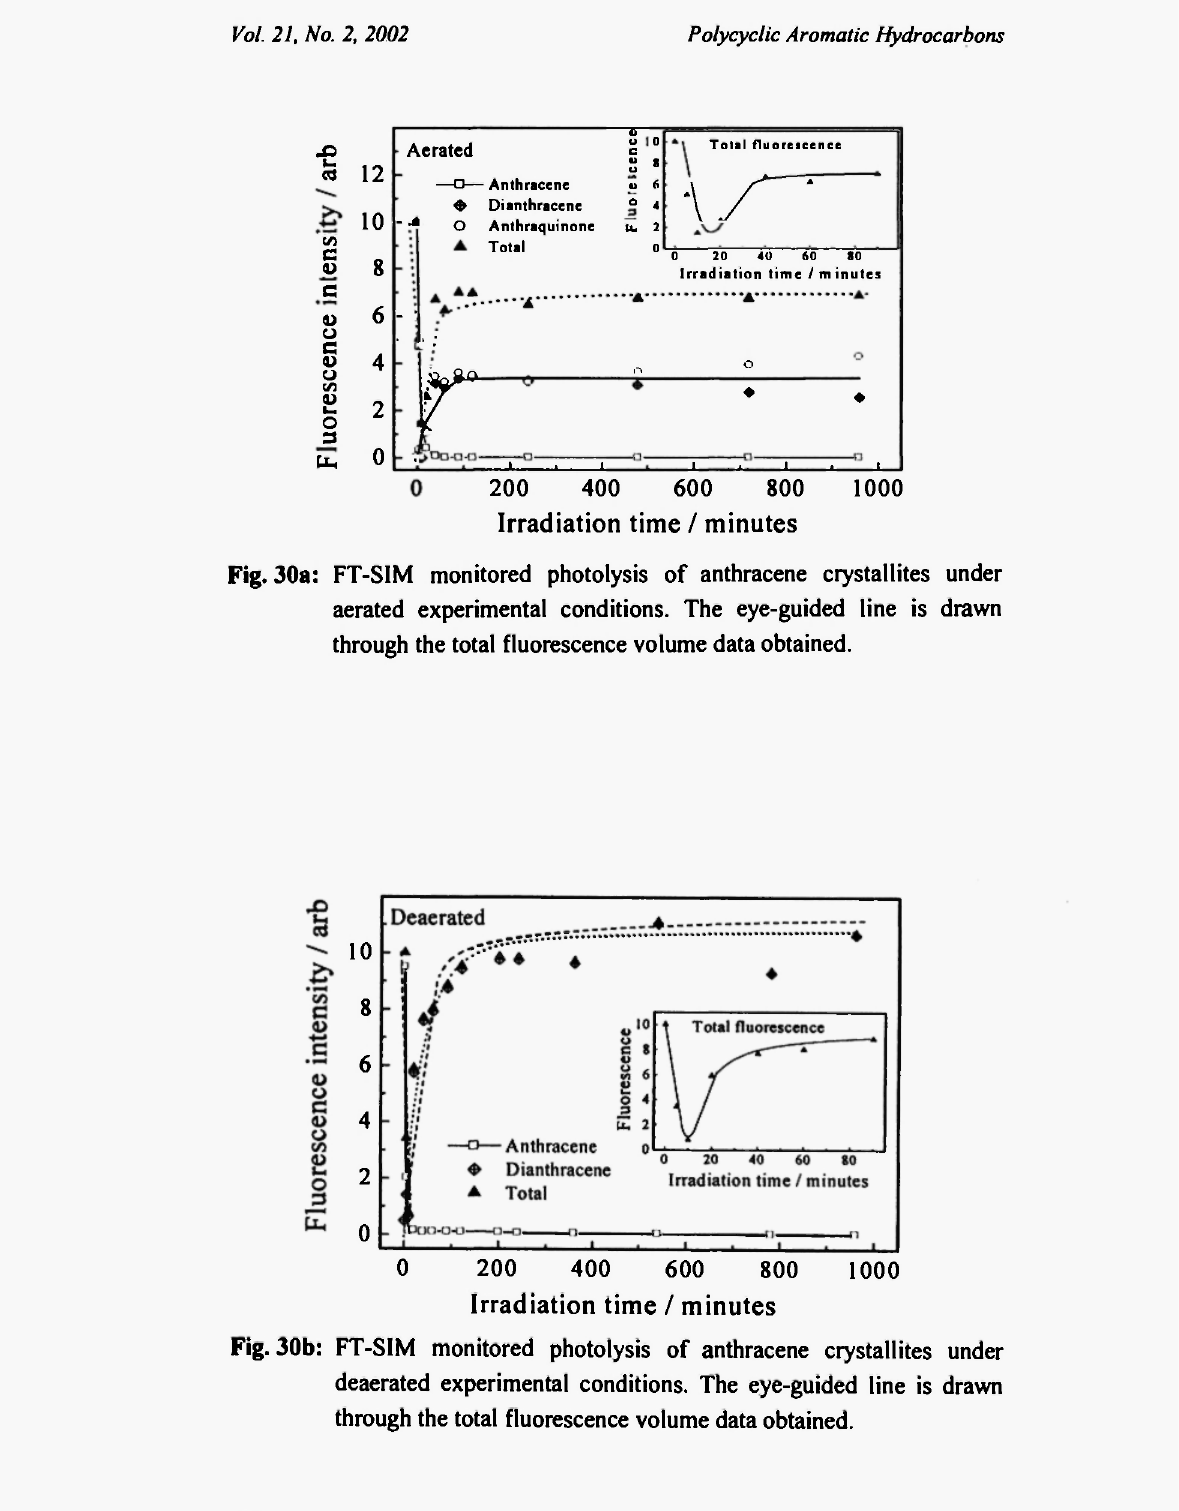
Fig. 30b: FT-SIM monitored photolysis of anthracene crystallites under deaerated experimental conditions. The eye-guided line is drawn through the total fluorescence volume data